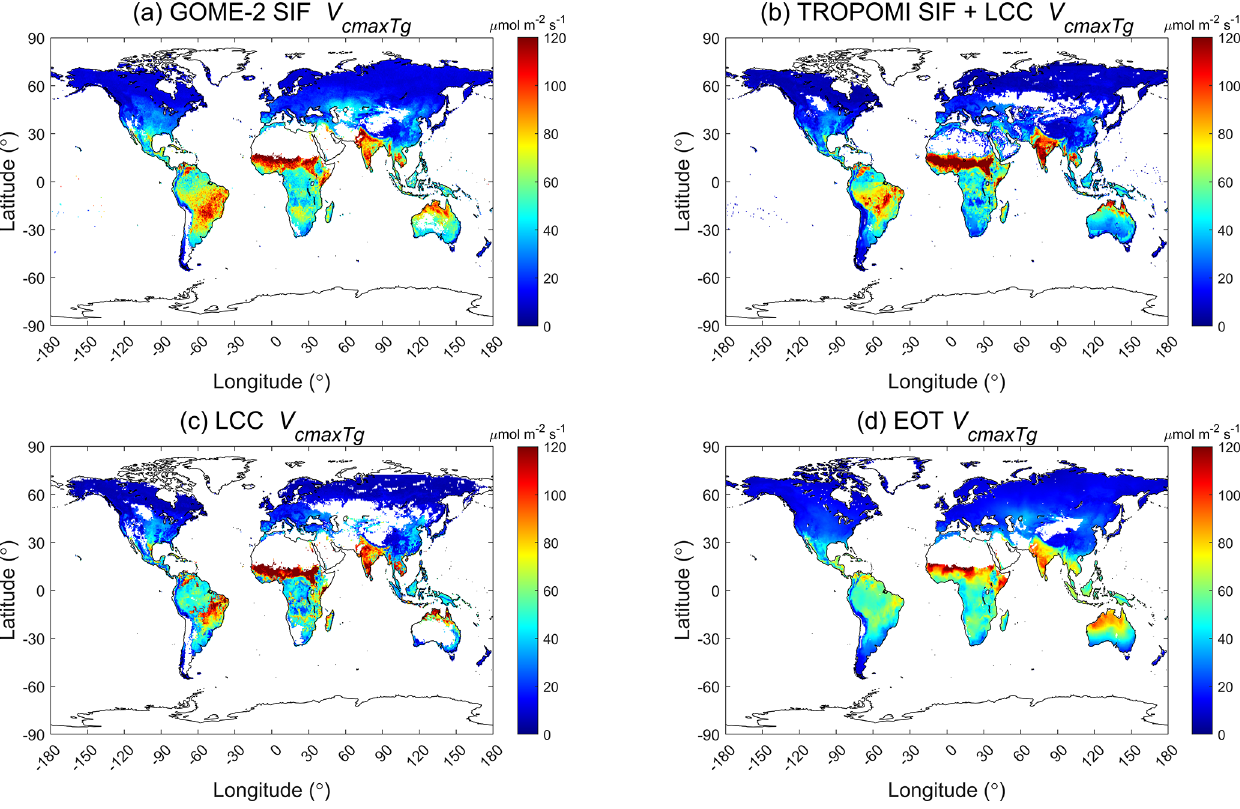
at the mean growing season temperature derived using (a) GOME-2 SIF (2007–2011), (b) Figure 1. Global distributions of V cmax T g TROPOMI SIF + LCC (2019) constrained by leaf chlorophyll content (LCC), (c) LCC (2017), and (d) ecological optimality theory (1901– 2015). White areas are missing data.